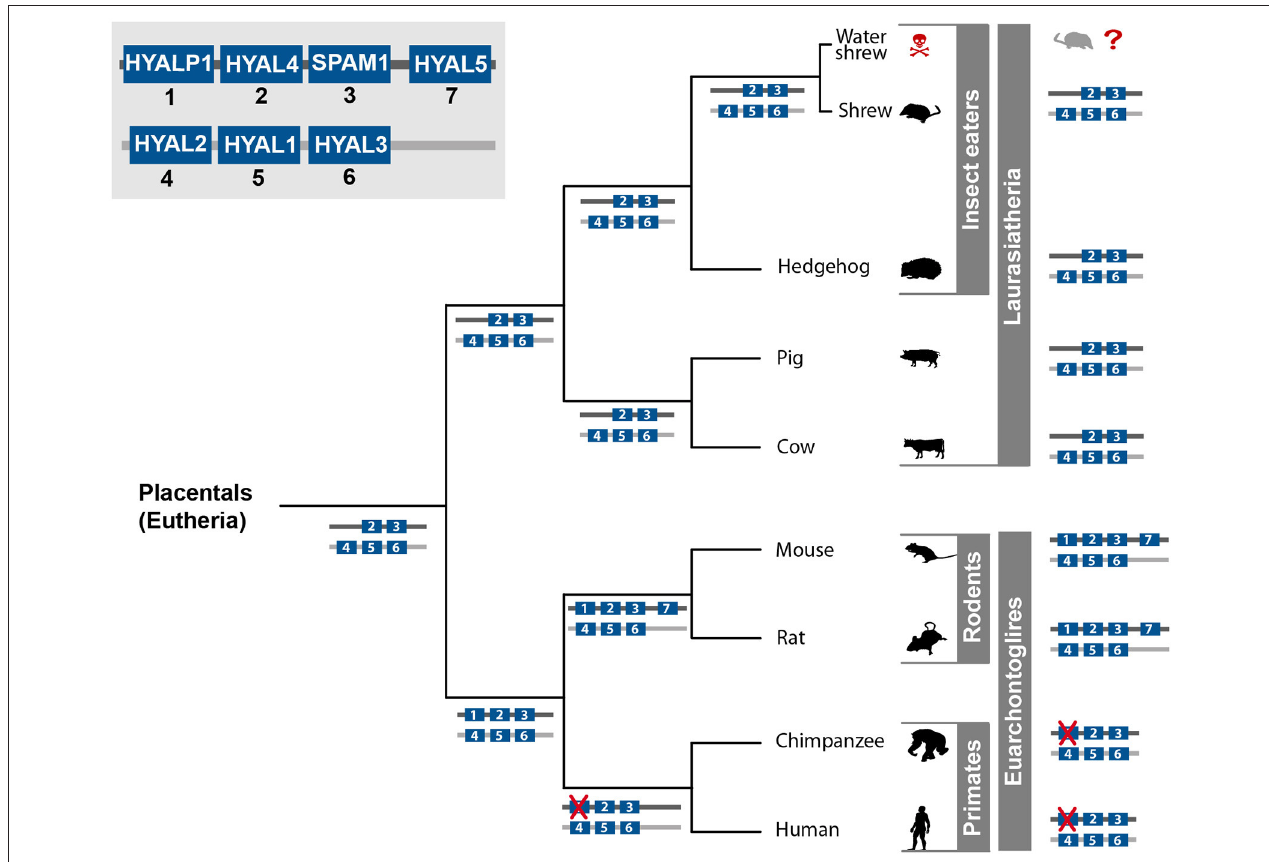
FIGURE 3 | Hyaluronidase gene evolution in placental mammals. All seven known hyaluronidase variants are depicted in the left upper corner. Which gene clusters and variants occur in the separate lineages of placental mammals is illustrated by the numbered gene blocks in blue on each lineage and for each species. Genes that are crossed out in red symbolize pseudogenization. Animal silhouettes were taken from PhyloPic (PhyloPic — Free Silhouette Images of Life Forms).